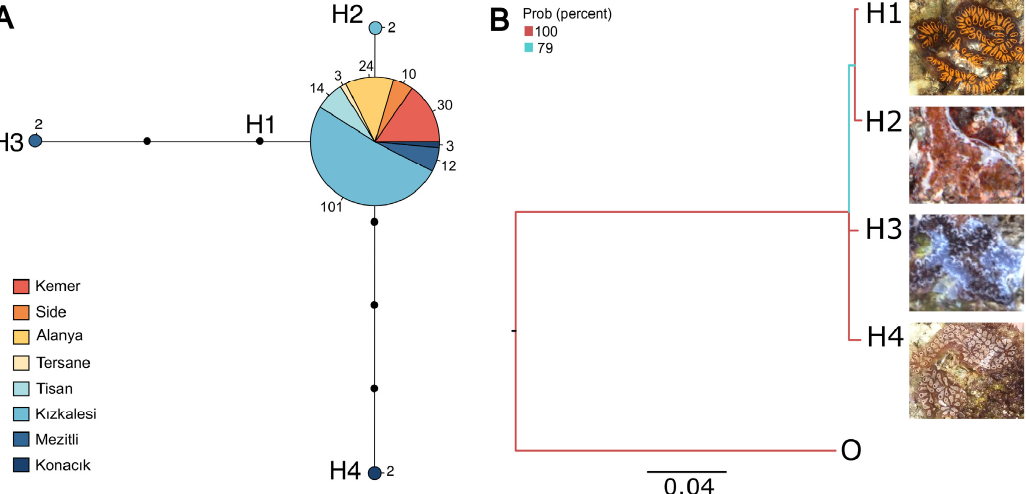
Figure 2. COI haplotype network of B. niger from the NEMS. ( A ) Minimum spanning network based on COI haplotypes of B. niger locus, overlaid with the corresponding haplotype name. Size differences of the circles indicate frequency, while colors reflect the regions where the colony was sampled. Numbers represent the number of samples in each category, and each correcting edge indicates a distance of one mutation step between the haplotypes. ( B ) Phylogenetic distance between the COI haplotypes is depicted by the best Bayesian tree, together with representative images of each haplotype. The branch colors represent bootstrap probability. The tree was rooted with the outgroup species Symplegma brakenhielmi .